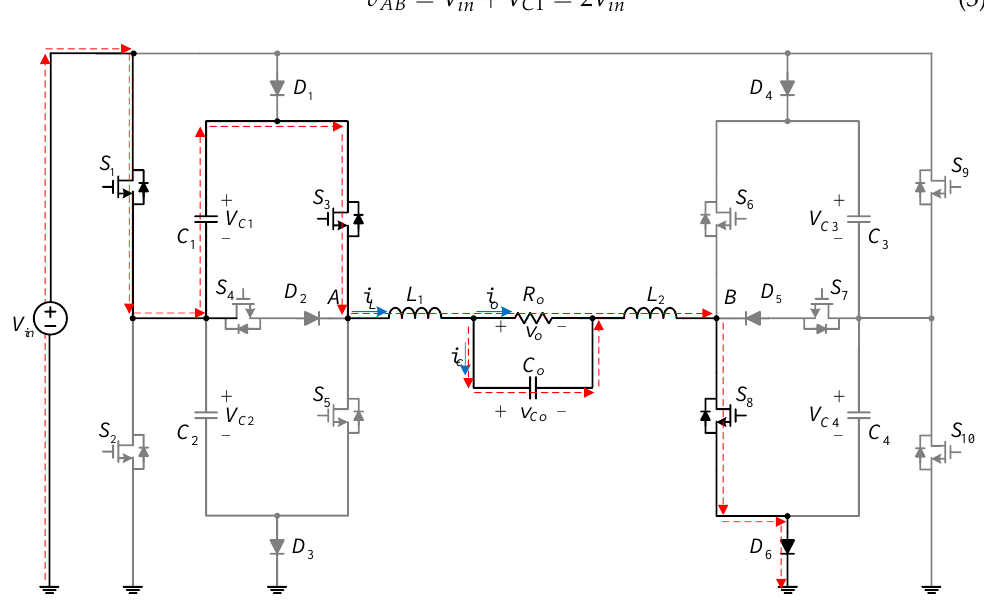
Figure 7. Power flow as S 3 is conducted.